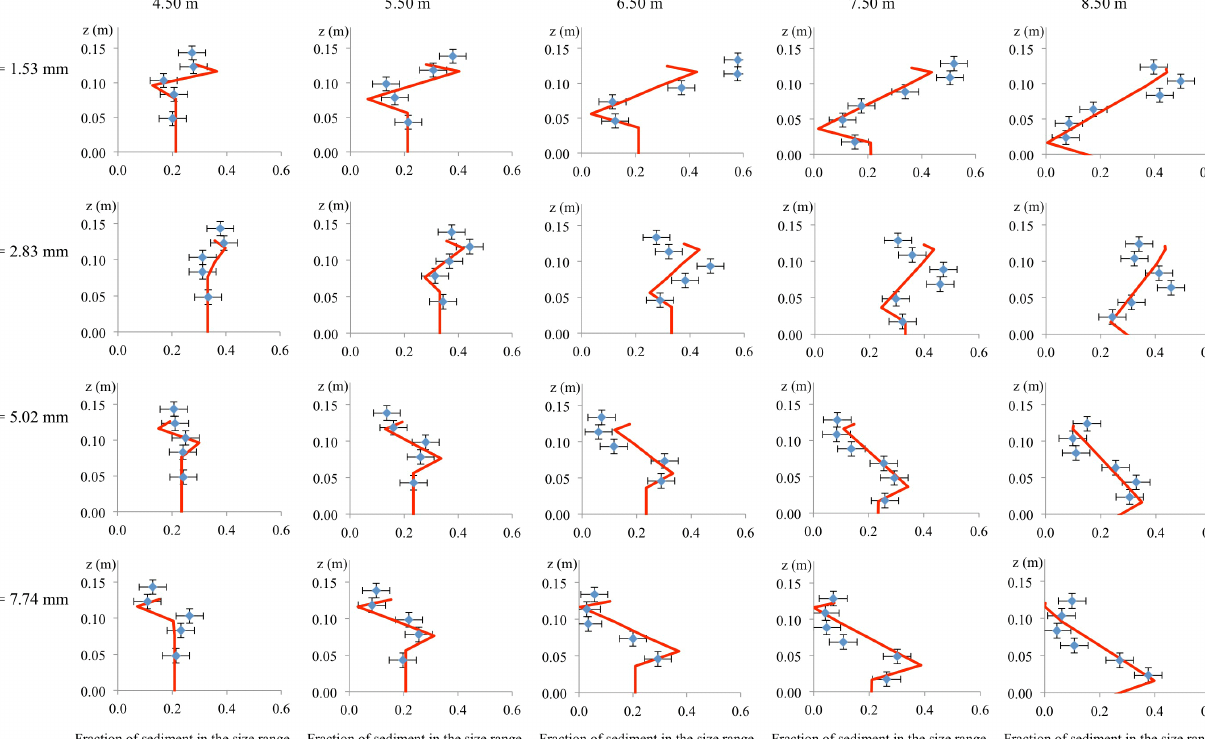
Figure 10. Comparison between measured and numerical grain size distribution of the front deposit. The diamonds are the experimental data, and the lines are the numerical predictions. Horizontal error bars denote a ± 5% error. The vertical elevation above the datum, z , of the diamonds corresponds to the elevation of the center of the sample. The vertical error bars at ± 1cm denote the thickness of the sampled